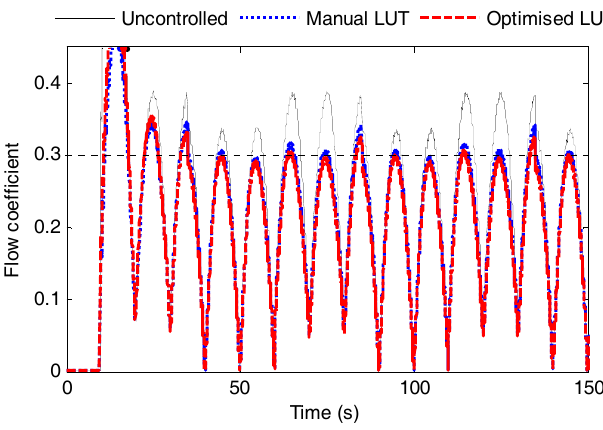
Figure 12. Flow coefficient for MPPT algorithm under irregular waves.